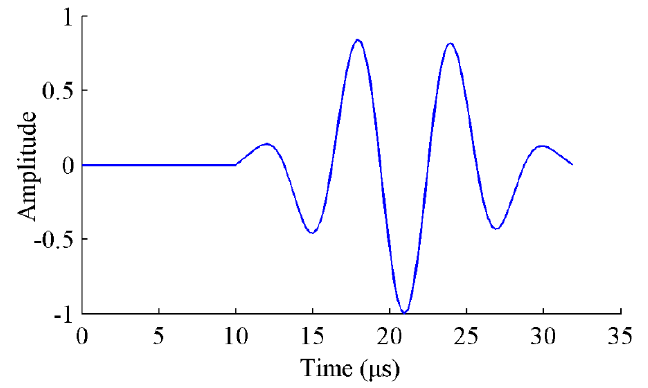
Figure 1. The 3.5-cycle excitation signal for Lamb wave.